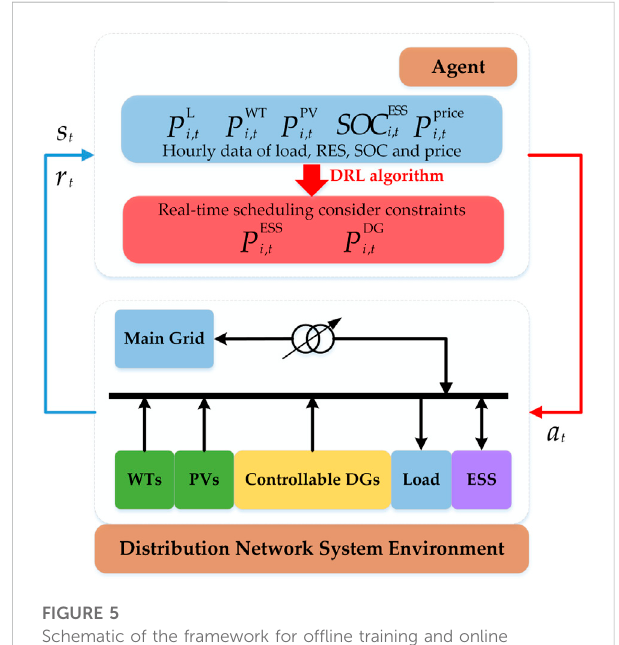
FIGURE 5 Schematic of the framework for of fl ine training and online